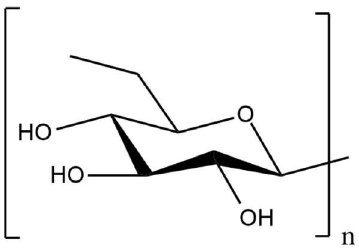
Figure 7. The chemical structure of lasiodiplodan. Given its wide range of biological functions, including protective activity against induced DNA damage by doxorubicin, anticoagulant, and hypoglycemic activities, and a decrease of transaminase activity in rats without any hematologic or histologic changes that indicate toxicity in the vital organs [121,122], lasiodiplodan exopolysaccharide presents a significant commercial potential